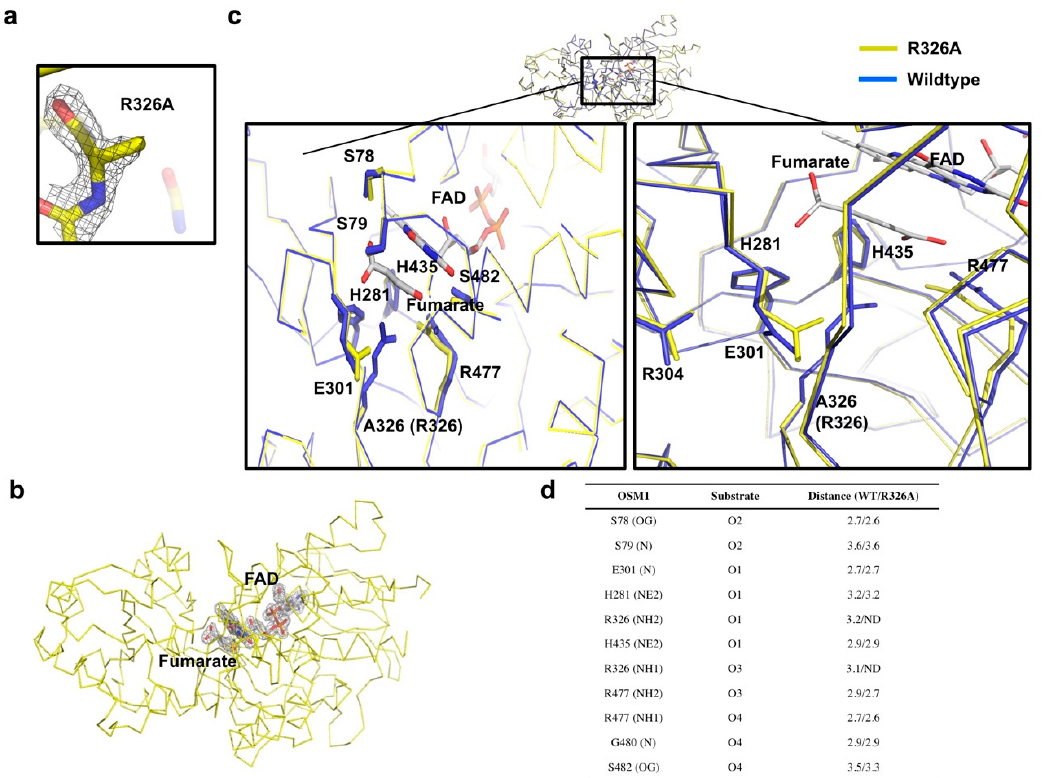
Figure 2. Active site of Osm1 R326A: ( a ) Omit density map contoured at the 1- σ level around the mutated residue, R326A; ( b ) omit density map contoured at the 1- σ level around the active site of Osm1 R326A; ( c ) details of the active site structure; the active site is presented by a black rectangle; the magnified structures of the R326A region, the FAD, and the substrate binding site are depicted at the left and right panels, respectively; ( d ) details of the interaction between the substrate and surrounding